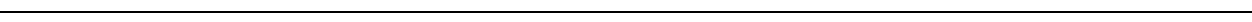
Fig. 5 Co-representation of hue and object identity in color patches. a Comparison of MDS plots of responses to all human face images in all three color patches and outside color patches. For clarity, the original natural color images are not shown. In ALC and AMC, the images were clearly grouped according to hue, while in CLC, this grouping is less clear. Outside the color patches, images were grouped according to identity, but not hue. b Population similarity matrices computed from responses to human face images in three color patches and outside color patches. Correlation coef fi cients were computed between responses to 11 identities and 8 hues. c Hue information and identity information for images of 10 categories in three color patches and outside color patches. Hue information was quanti fi ed as the mean correlation between responses to images with the same hue, but different identity within the same category, while identity information was quanti fi ed as the mean correlation between responses to images of the same identity with different hues. Note that here we are quantifying shape-invariant hue tuning, which will be affected by both shape tuning and color tuning; in particular, cells with strong shape tuning will show low shape-invariant hue tuning, even if they have perfectly consistent hue tuning across shapes. Error bars represent s.d. of 2000 iterations of bootstrapping. Statistical signi fi cance was determined between hue and identity information for each category in three color patches and outside color patches (* p < 0.05, ** p < 0.01). d Amplitudes of hue and identity information for three patches and outside color patches, computed over a 50 ms sliding time window, were averaged across all 10 categories. Shaded regions indicate s.d. estimated by 2000 iterations of bootstrapping. e Co-representation of hue and category in all three patches and outside color patches. Responses of each cell were averaged across different identities within a category. A matrix of correlation coef fi cients was computed between responses to 10 categories* 8 hues. f and g Same as c and d , but for hue and category information quanti fi ed by matrices in e , ** p <